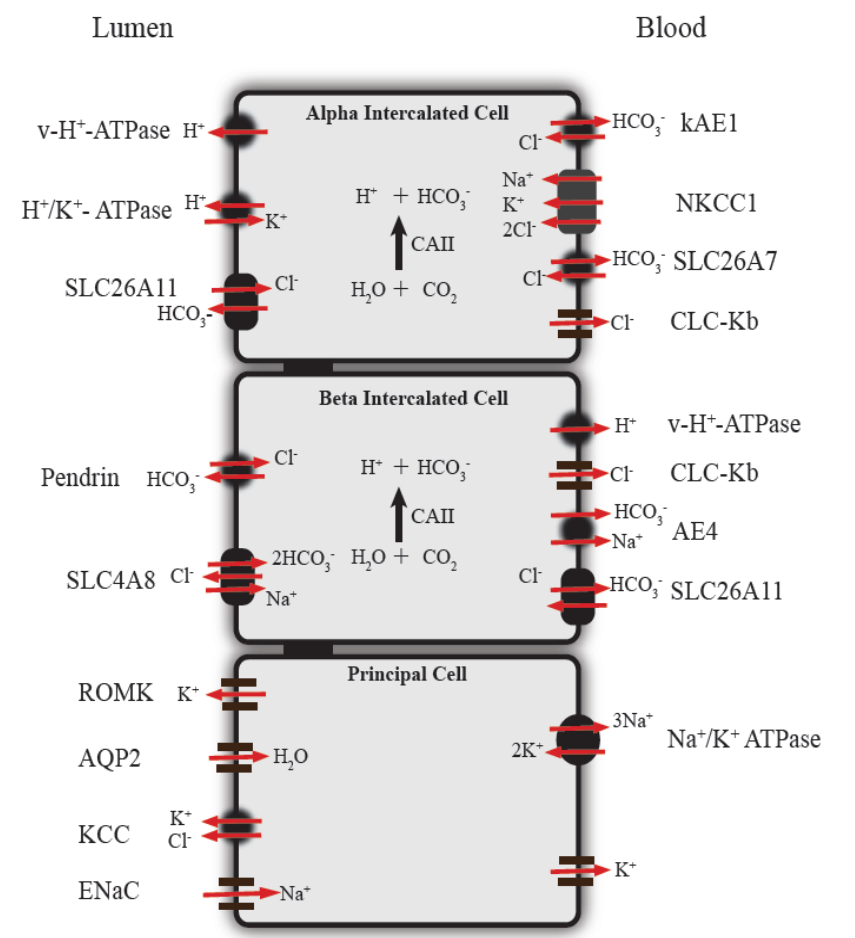
Figure 2. Model illustrating the collecting duct cell types. Type-A intercalated cells secrete protons into the lumen through the apical vacuolar H + -ATPase proton pump and − in exchange for Cl − through the basolateral the H + /K + -ATPase, and reabsorb HCO 3 kidney by carbonic anhydrase II (CAII). Additionally, these cells express two potential chloride/bicarbonate exchangers, the basolateral SLC26A7 and the apical SLC26A11. The Na + -K + -2Cl − cotransporter (NKCC1) is also expressed at the basolateral membrane of these cells, along with the chloride channel ClC-Kb. Type-B intercalated cells secrete − into the lumen through apical pendrin and protons are effluxed into the blood HCO 3 through the basolateral vacuolar H + -ATPase. These cells also express the ClC-Kb chloride channel and SLC26A11 at their basolateral membrane. At the apical membrane, pendrin’s function is coupled to that of SLC4A8 to promote sodium and chloride reabsorption. Principal cells regulate ion homeostasis by expressing the epithelial sodium channel (ENaC), a K + /Cl − cotransporter (KCC), the water channel aquaporin 2 (AQP2) and the renal outer medullary potassium (ROMK) channel in their apical plasma membrane, and the sodium/potassium ATPase at the basolateral membrane. So far, no basolateral chloride channel has been identified in these